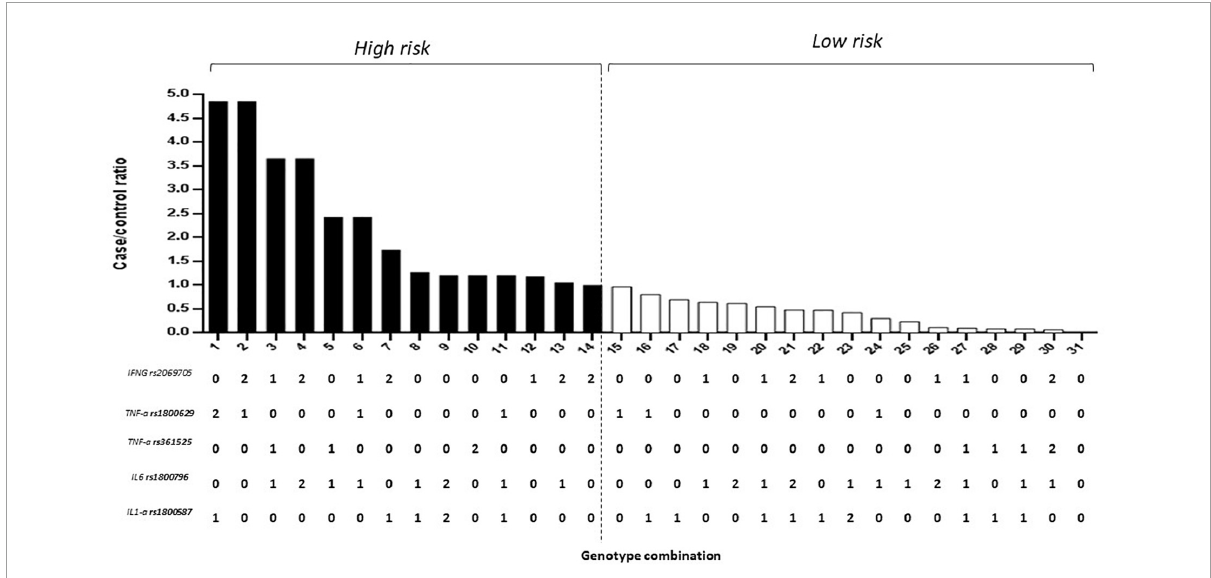
FIGURE2 Five-locus gene–gene interaction between IL-1 α (rs1800587), IL-6 (rs1800796), TNF α (rs361525 and rs1800629), and IFN γ (rs2069705) for dementia. The bar graph shows the validation of high and low-risk classifications. Genotype coding is as follows: 0, homozygous common allele; 1, heterozygous; and 2, homozygous variant